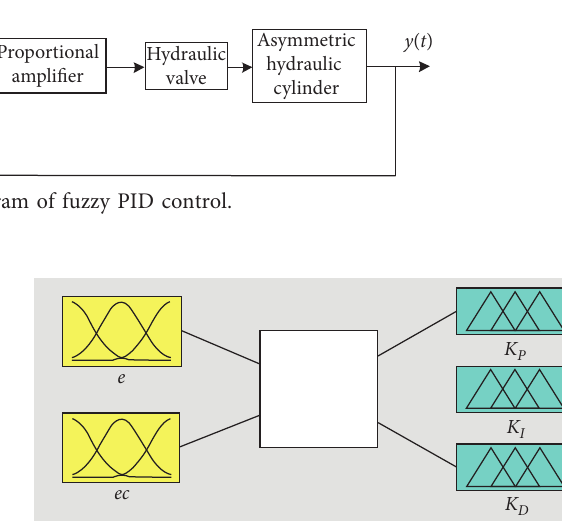
Figure 4: Structure of fuzzy